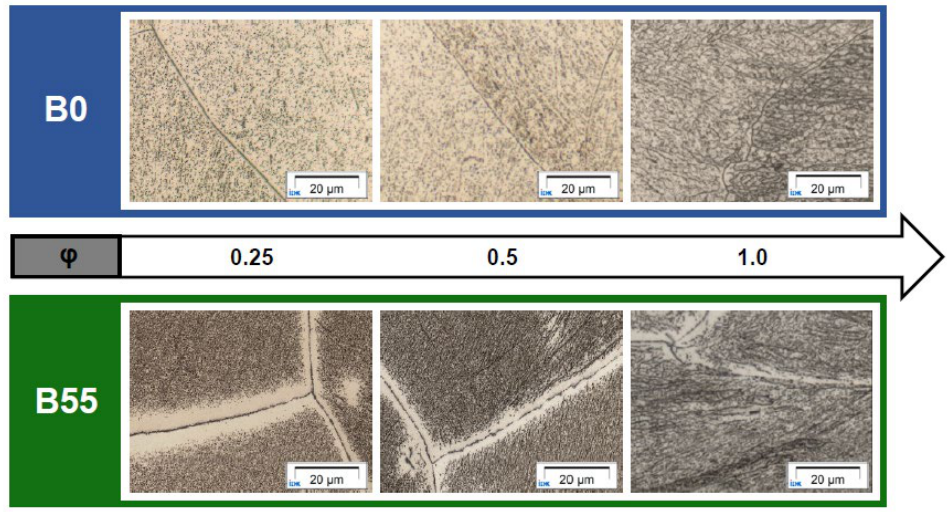
Figure 6. Impact of the deformation grade variation (0.25/0.5/1) at an 800 °C deformation tempera- ture on precipitation in the reference B0 in comparison to the boron-alloyed B55 steel.